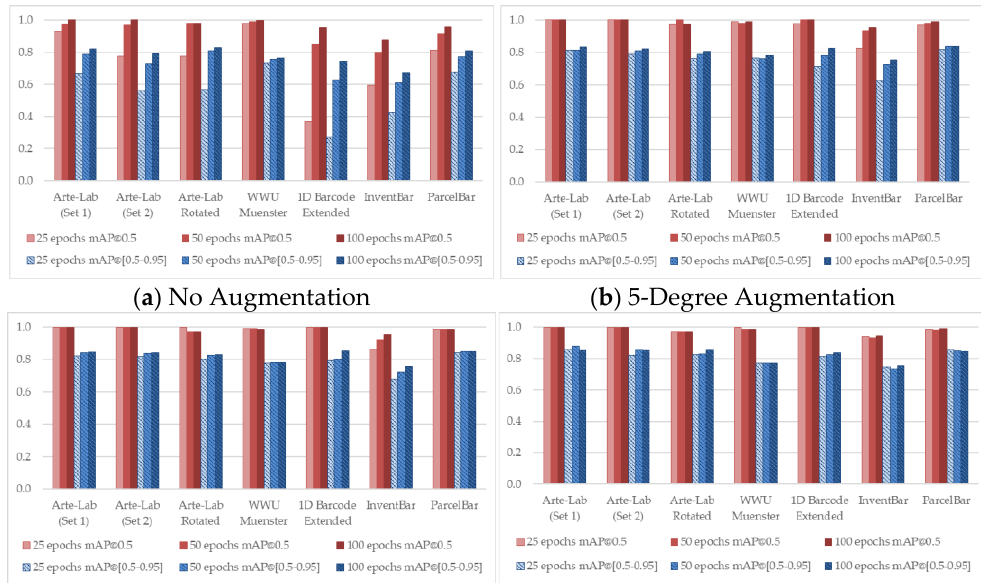
Figure 4. Recognition rate of EfficientDet applied over seven public barcode datasets.